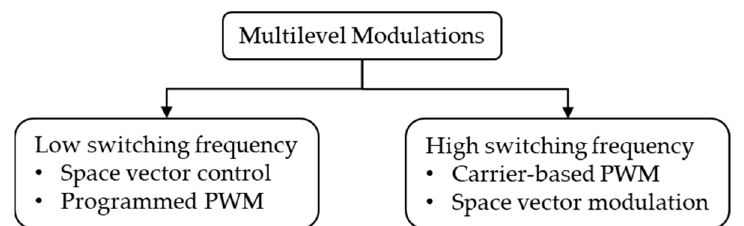
Figure 3. Basic classification of modulations for multilevel converters.